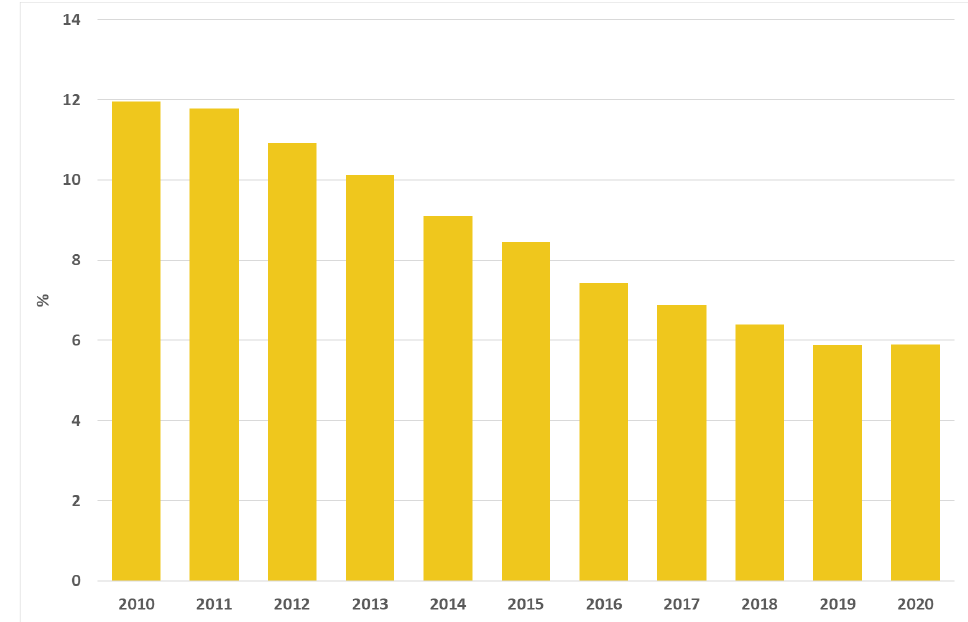
Figure 5. Proportion of reoperation within 90 days of breast-conserving surgery from 2010 to 2020.